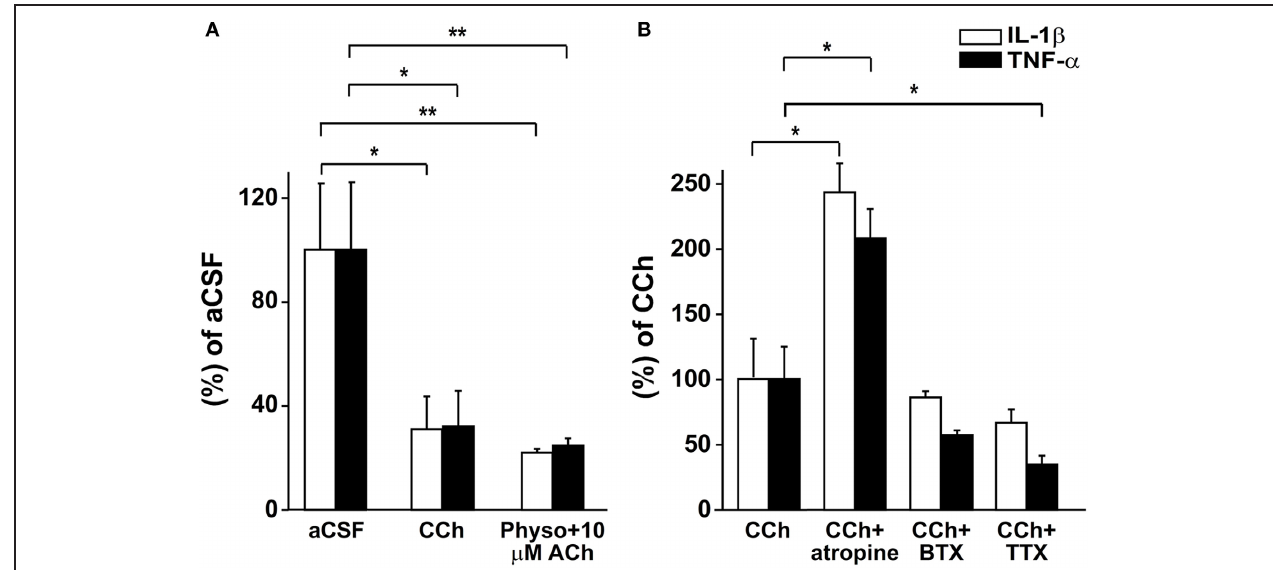
FIGURE 5 | Real-time RT-PCR for IL-1 β and TNF- α in acute slices. (A) mRNA relative levels in slices treated with aCSF, 50 μ M CCh ( ∗ p = 0 . 025; n = 6) or 1 μ M physostigmine with 10 μ M ACh ( ∗∗ p = 0 . 006; n = 5–6). (B) mRNA relative levels in slices treated with 50 μ M CCh ( n = 5) and 50 μ M